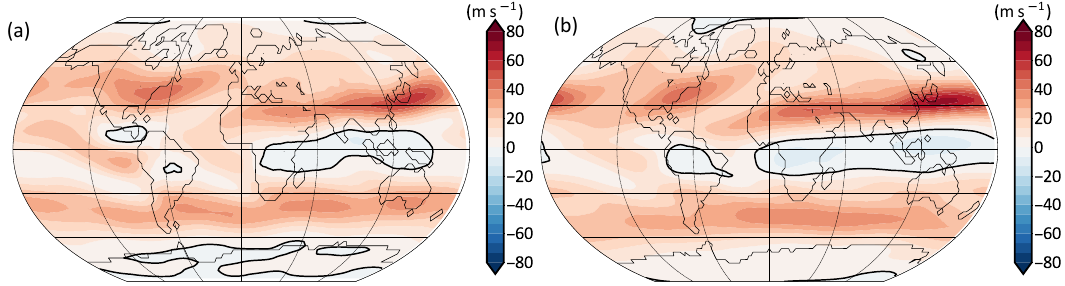
Figure 7. As in Fig. 6 but showing the zonal wind at 250hPa, with Isca results on the left and the JRA-55 reanalysis on the right. The thick black line is the zero